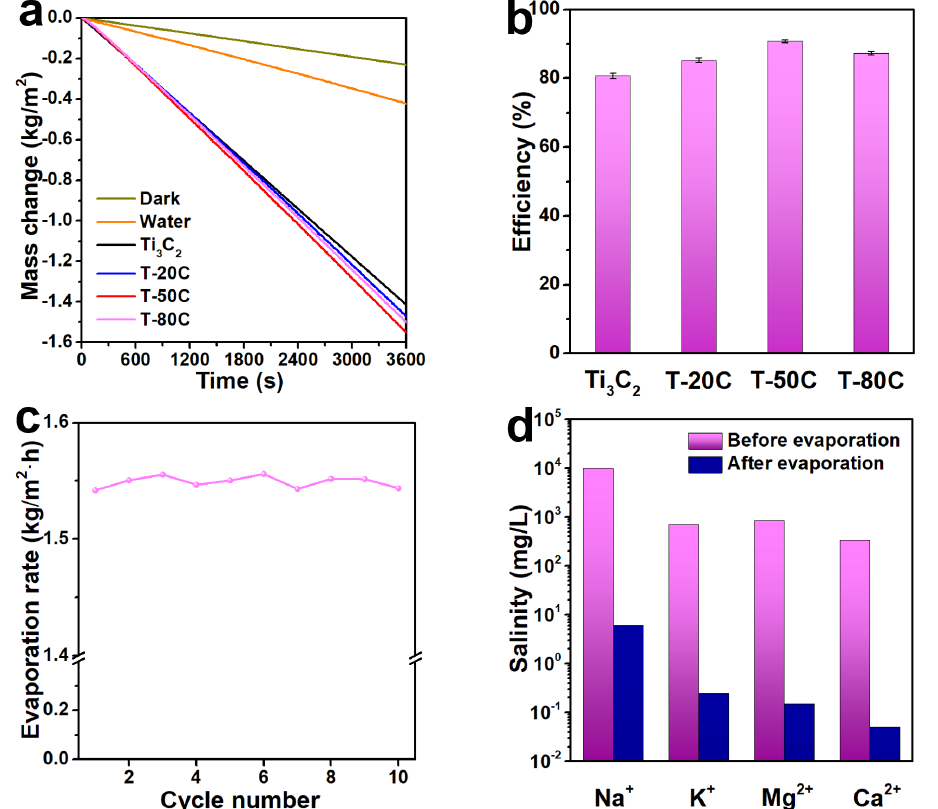
Figure 4. ( a ) Water weight loss through solar evaporation, ( b ) the corresponding solar-to-vapor conversion efficiency, ( c ) cycle running and ( d ) salinity before and after solar desalination.